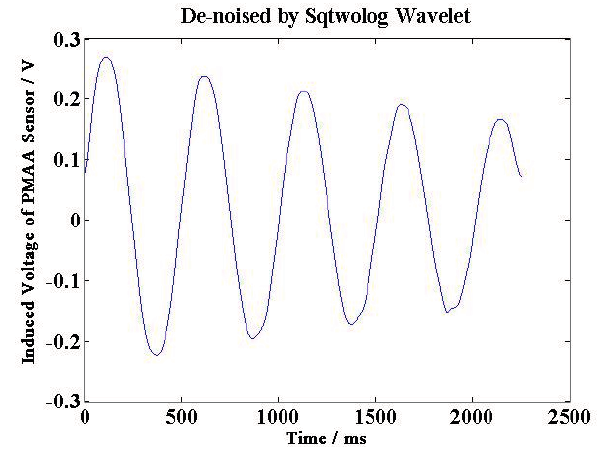
Figure 22. The sensor output signals de-noised by sqtwolog